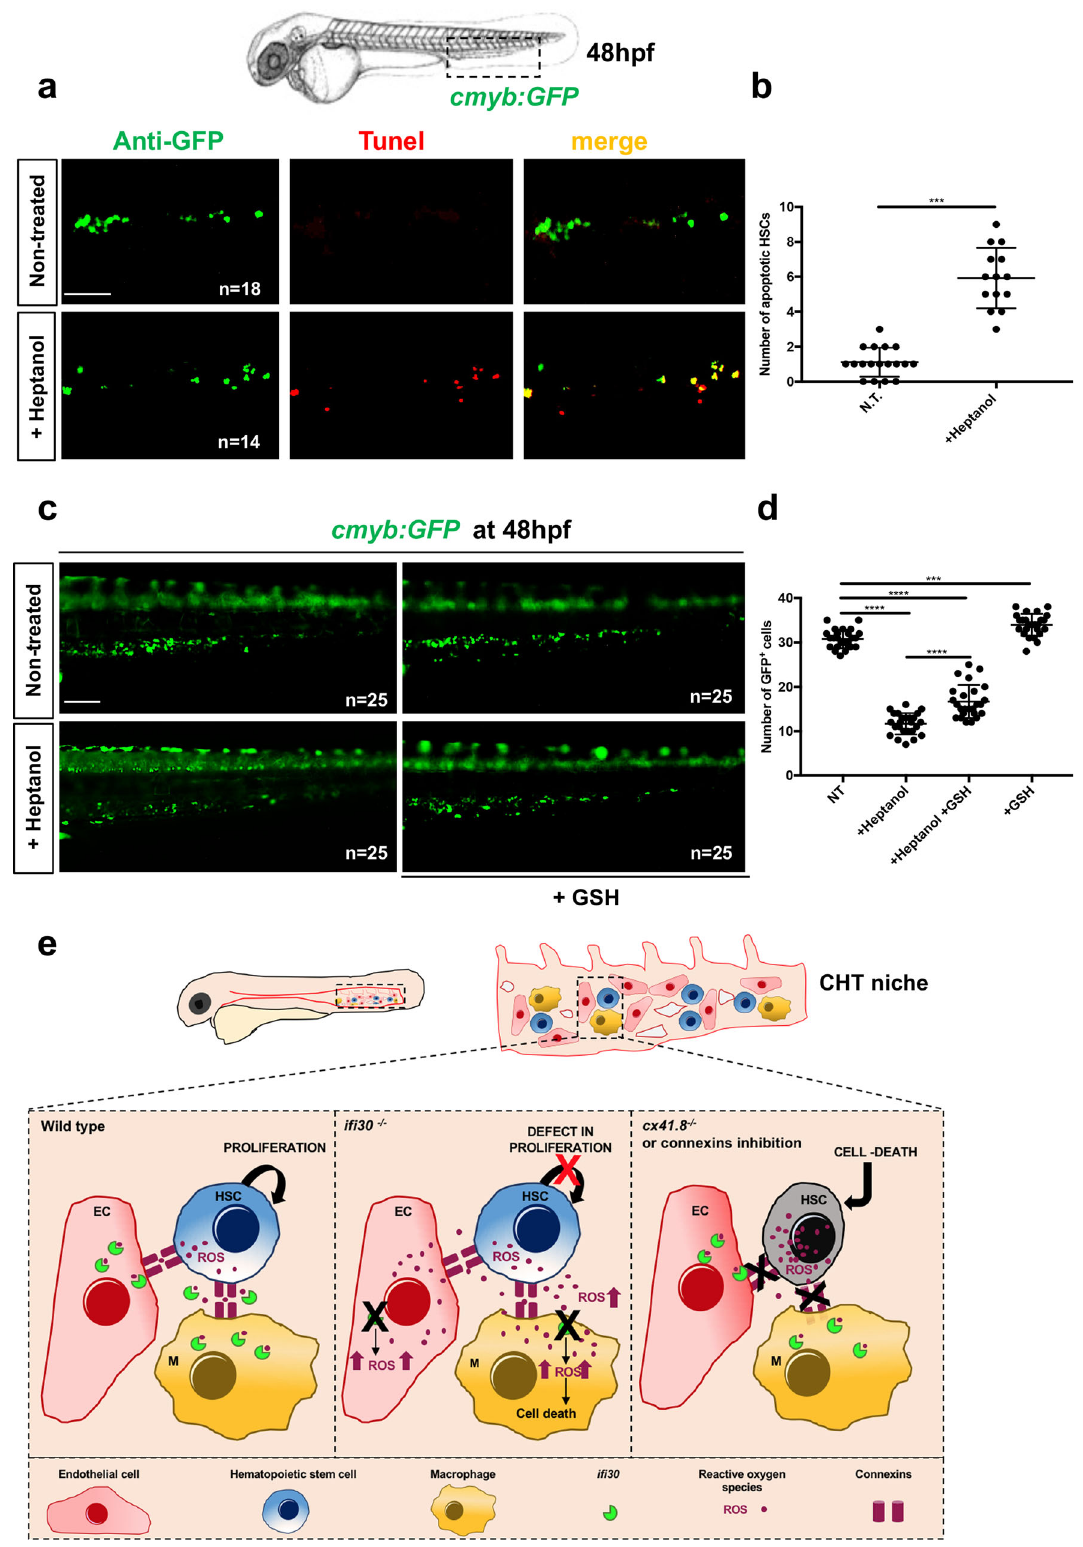
Drug exposure and analysis . The concentrations of all chemical treatments were chosen based on previous studies which established that these doses produced sub- lethal effects in zebra fi sh embryos, with no gross malformations 11,36,56 . All com- pounds used in these experiments were purchased from Sigma-Aldrich. Zebra fi sh embryos were exposed for three hours to 3mM of H 2 O 2 starting at ∼ 45hpf. For chemical treatments, the embryos were exposed to 10µm of NAC or L -glutathione reduced (GSH), Menadione, BSO, oxidized glutathione (GSSG) from 36hpf to 48